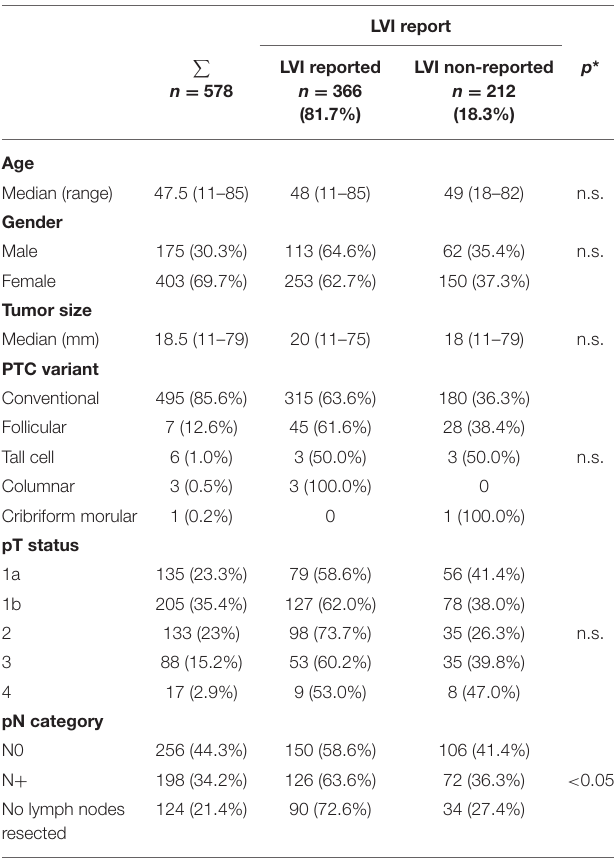
TABLE 1 | Lymphatic vessel invasion (LVI) report and clinicopathologic variables (* p -values are calculated for LVI reported vs.